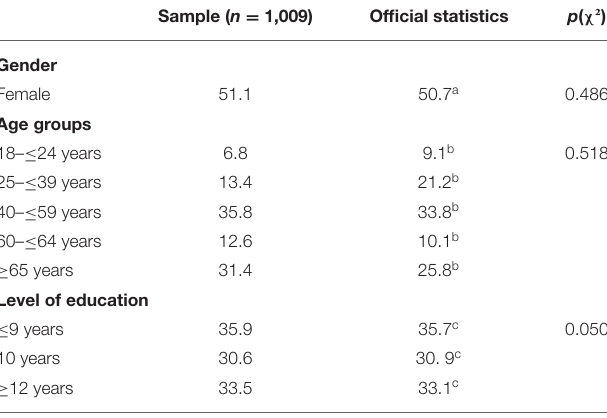
TABLE 1 | Sociodemographic variables of the sample compared to official statistics (in